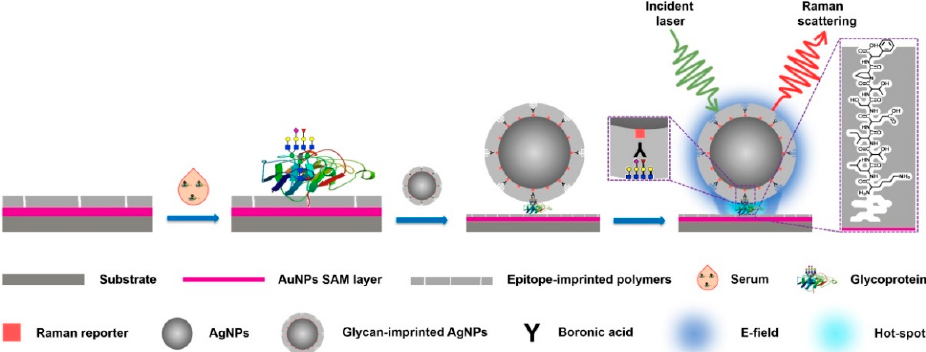
Figure 15. Schematic illustration of odMIP-PISA approach for detection of trace target glycoprotein in complex sample. Reprinted from ref. [193]. Copyright (2019) with permission from Elsevier.